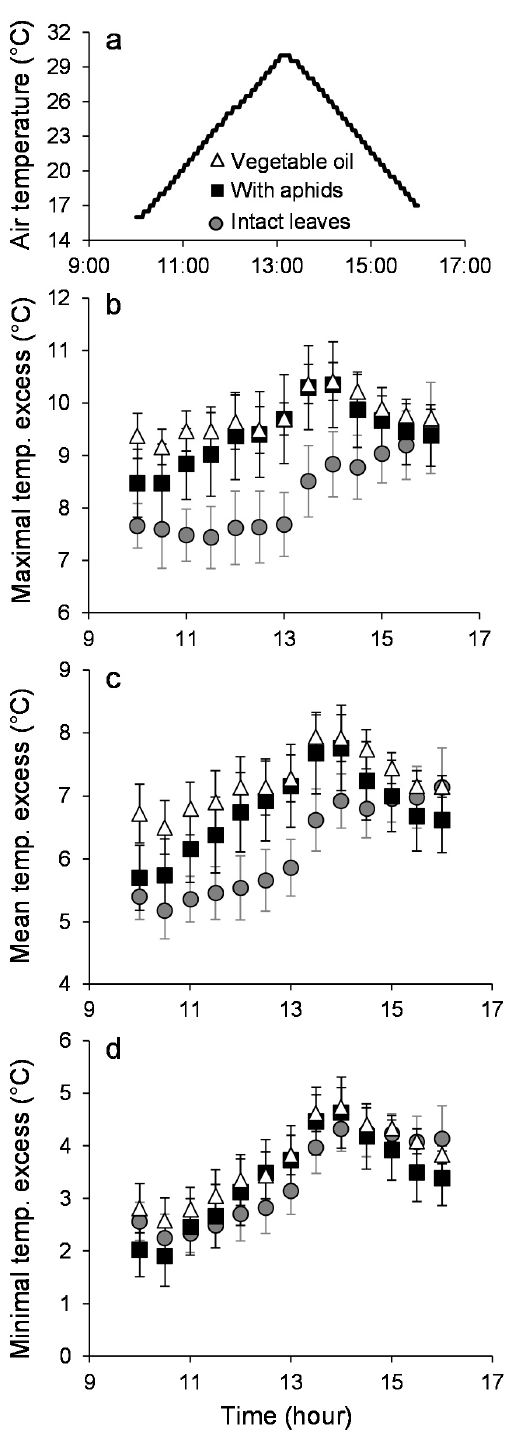
Figure A5. Dynamics of the temperature patterns during the six-hour experiment. ( a ) Air temperature pattern in the climatic chamber from 11:00 to 16:00. ( b – d ) Dynamics of the leaf surface temperature excess for the maximal ( b ), mean ( c ) and minimal ( d ) leaf temperatures (mean+se for each time step, i.e., every 30 min), and for the three treatments: intact leaves (grey circles), leaves covered with vegetable oil (white triangles) and leaves infested with green apple aphids (black squares). The minimal and maximal temperatures correspond to the mean temperature of the 5% coolest and hottest pixels at the leaf surface, respectively.